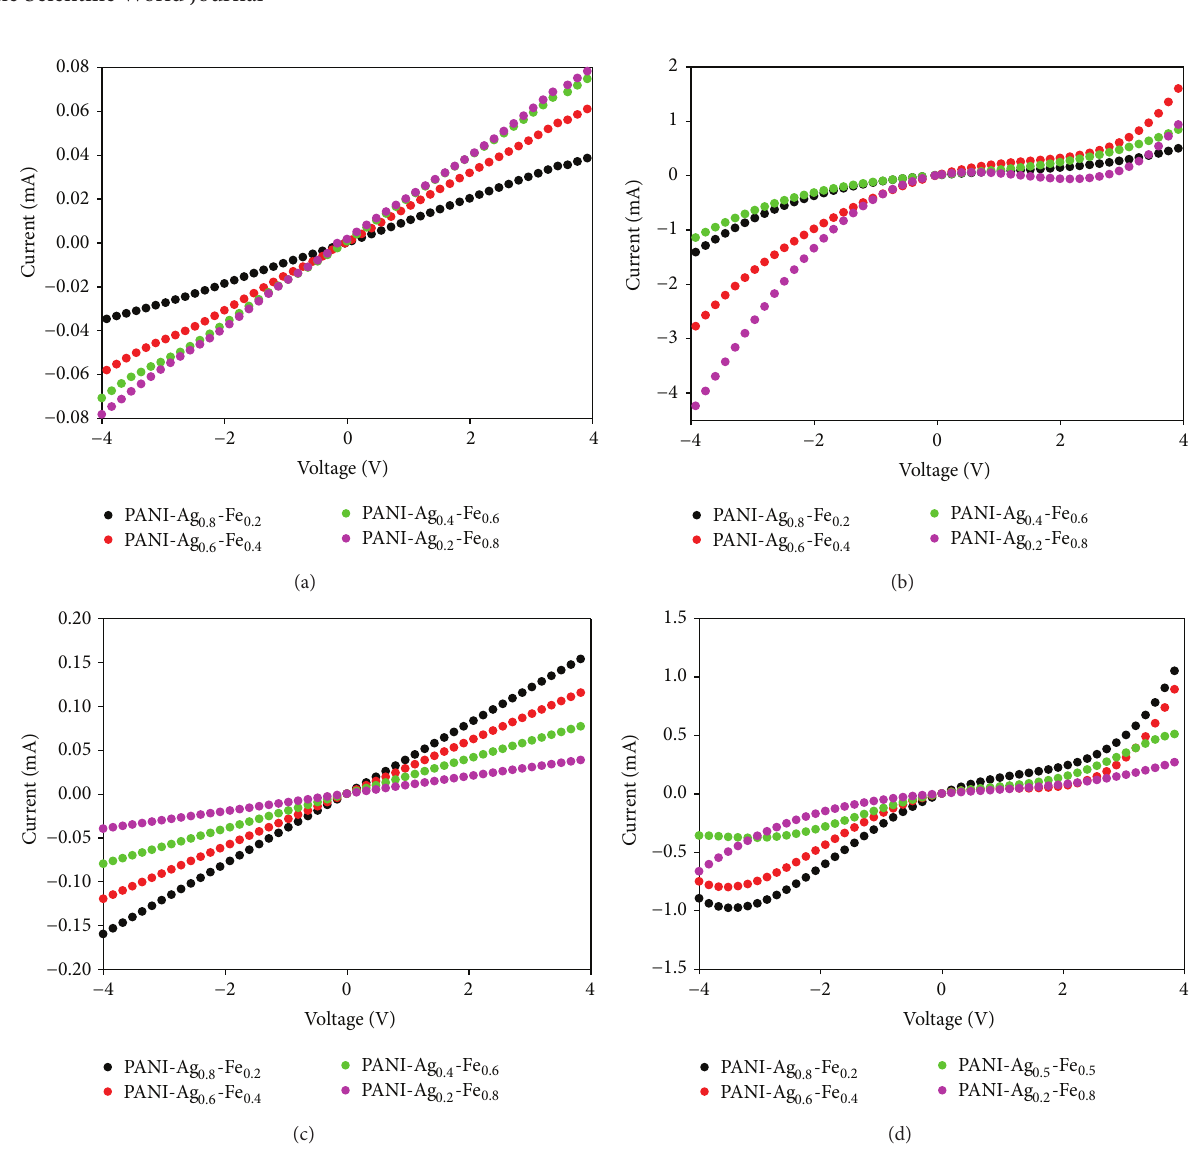
Figure 5: 𝐼 - 𝑉 measurement for PANI-Ag-Fe thin film sensor for the samples before annealing, (a) without E. coli , (b) with E. coli , and for the samples after annealing, (c) without E. coli , (d) with E. coli